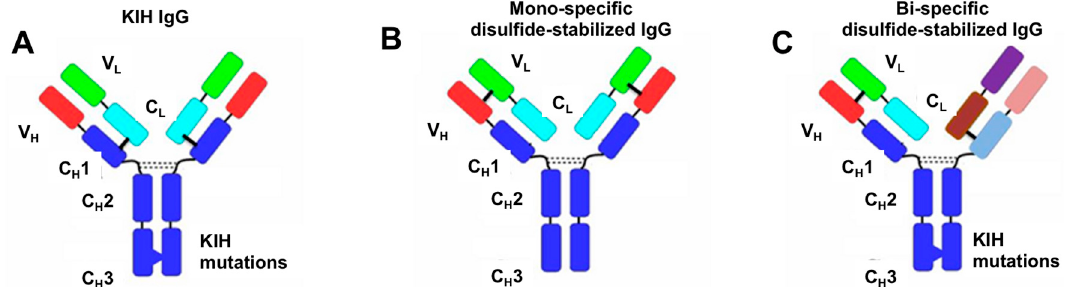
Figure 2. Schematic representation of our work strategy for production of mono- and bi-specific disulfide stabilized antibodies. ( A ) Scheme of an IgG antibody produced by the “knobs-into-holes” (KIH) approach (10), there are two different heavy chains but a common light chain; ( B ) Scheme of a mono-specific disulfide stabilized antibody (also named “disulfide-stabilized IgG”) which contains engineered disulfide bonds between antibody V H and V L domains symmetrically engineered in both Fab arms, with the native disulfide bonds connecting C L and C H 1 eliminated; ( C ) Scheme of a bi-specific antibody prepared according to our “BIClonals” approach. There are two different heavy chains, each paired to its cognate light chain. The KIH mutations correspond to T366W (“knob”), T366S, L368A, Y407V (“hole”), S354C and Y349C (cysteine replacement mutations at CH3 region of “knob” and “hole”, respectively). Fab arm interface disulfide-stabilizing mutations correspond to V H A44C and V H C222A, V κ A100C and C κ C214del, V- λ A100C and C λ C214A (or C214G that was used in the case of the anti streptavidin (SA) antibody).